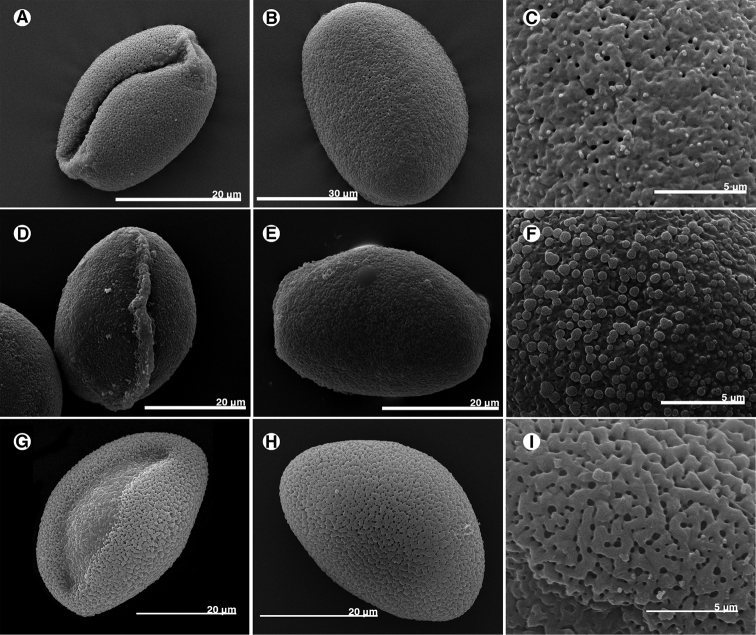
Pollen morphology of Disporum of Taiwan. A−CD.kawakamiiD−FD.sessilevar.intermediumG−ID.shimadae. A, B, D, E, G, H polar view C, F, I sculpture.